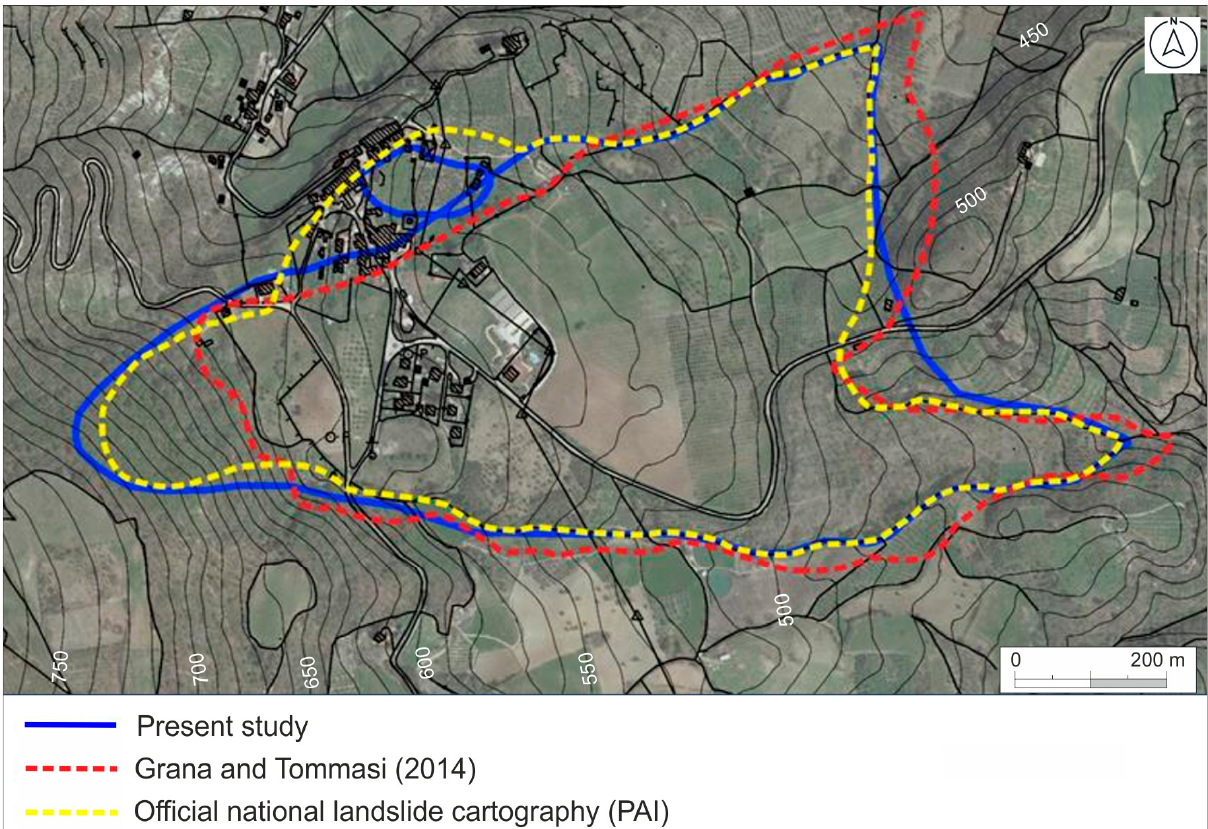
Figure 8. Comparison of the landslide polygon perimeter obtained in the present study with those reported by [33] and by the official national landslide cartography (Piano di Assetto Idrogeologico, PAI).